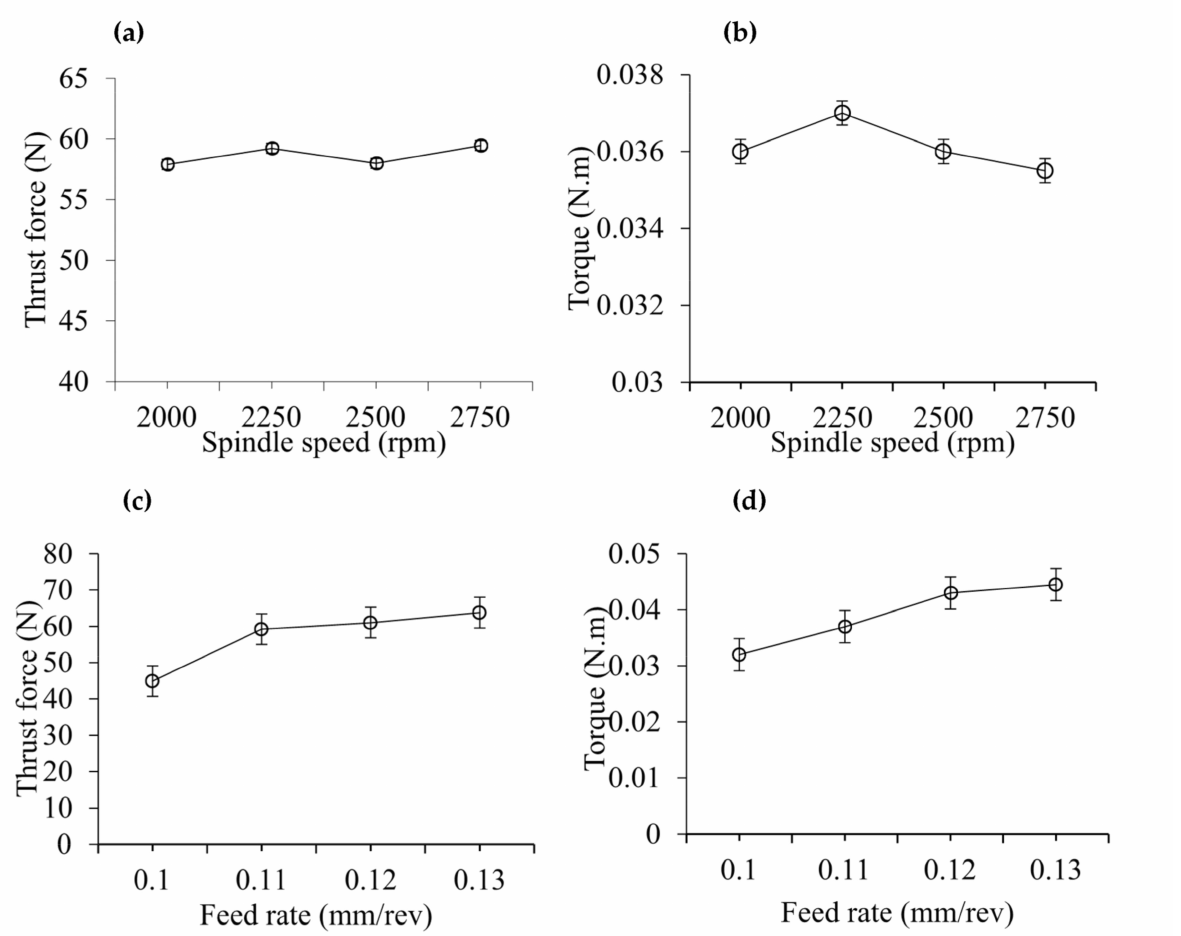
Figure 3. ( a , b ) Effect of spindle speed on thrust force and torque at drill bit diameter of 6 mm, point angle of 125 ◦ , 6 Scotch tape layers, and feed rate of 0.11 mm/rev, ( c , d ) Effect of spindle speed on thrust force and torque at drill bit diameter of 6 mm, point angle of 125 ◦ , 6 Scotch tape layers, and spindle speed of 2250